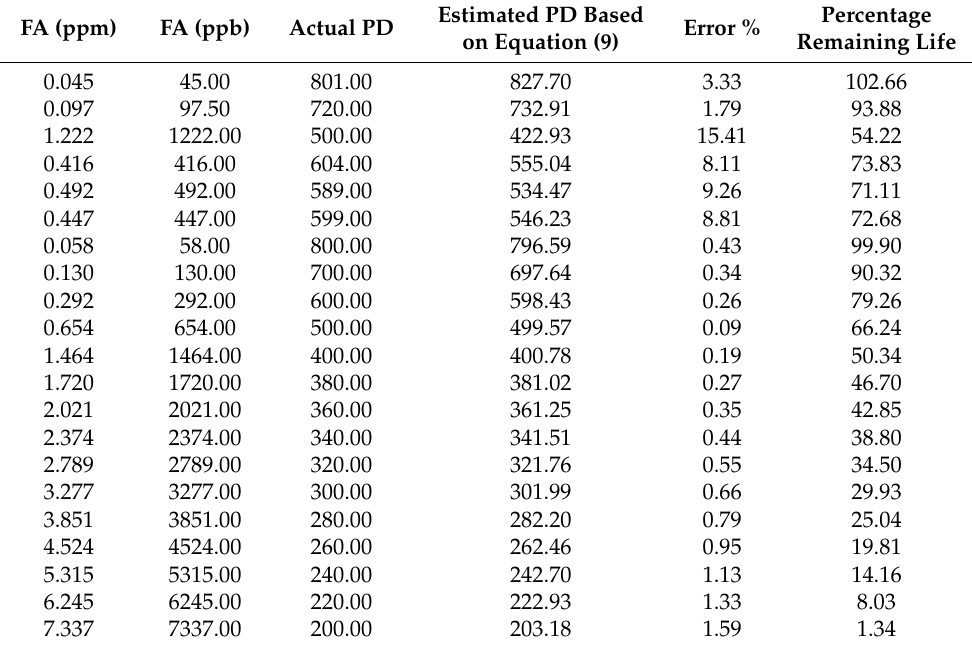
Table 8. Percentage of the remaining life of the power transformer based on the formula of Equation (10). FA